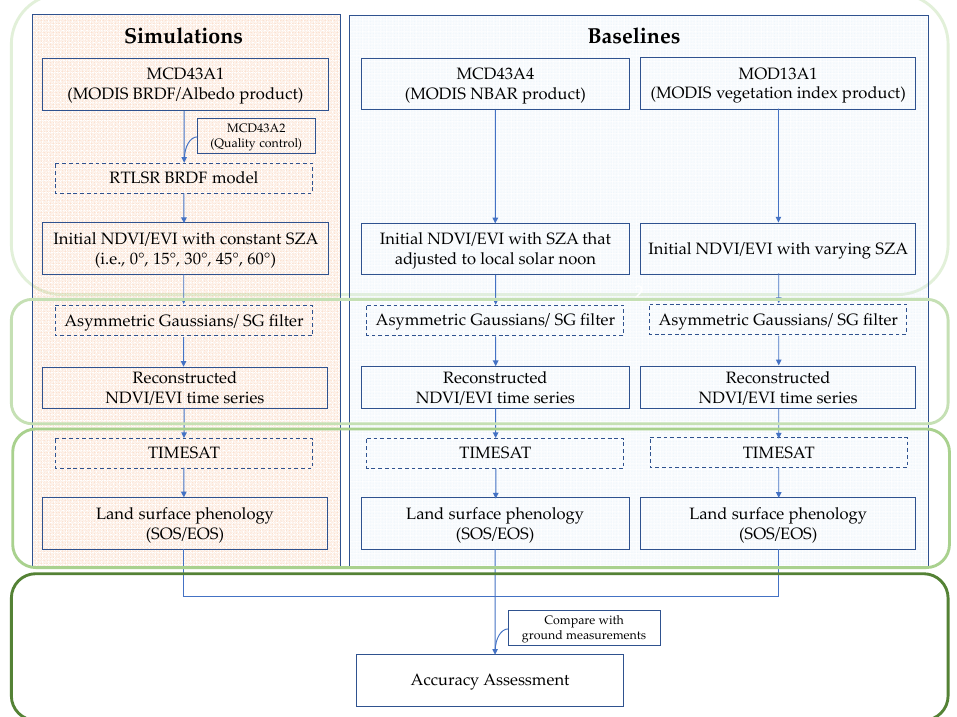
Figure 1. The process chain of deriving LSP from simulations with constant SZAs and from baseline products with inconsistent SZAs. The green rectangles from top to the bottom represent NDVI/EVI time series simulation based on the kernel-driven model, NDVI/EVI time series reconstruction, land surface phenology derivation, and accuracy assessment, respectively. Blue solid rectangles are used products or derived results, while blue dashed rectangles are used models or integrated algorithms.